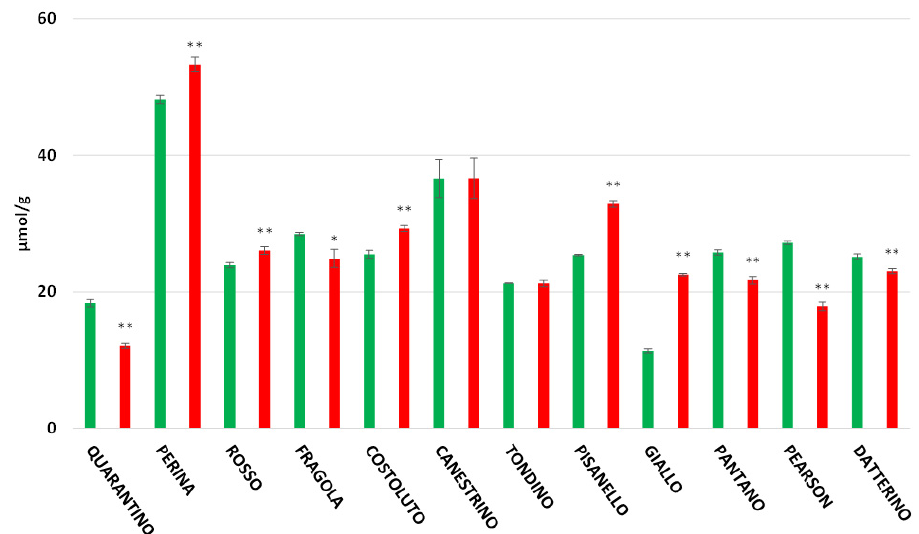
Figure 3. Total antioxidant (expressed as µmol/g of fresh weight (FW)) in tomato peel of 9 Italian cultivars and three commercial cultivars. Controls (CTRL) in green and drought-stressed group (DS) in red. The bars indicate the standard deviation. A significantly difference is shown between CTRL and DS of each cultivar by * for a p ≤ 0.05 and ** for p ≤ 0.01.